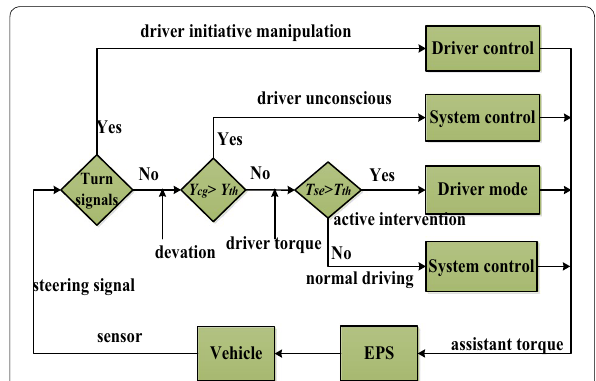
Figure 5 Driver state recognition